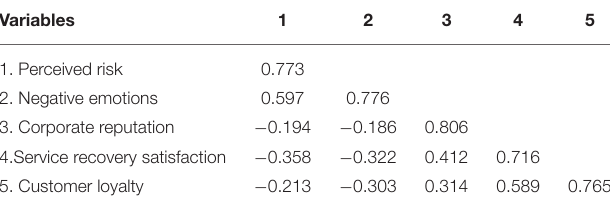
TABLE 3 | Test for discriminant